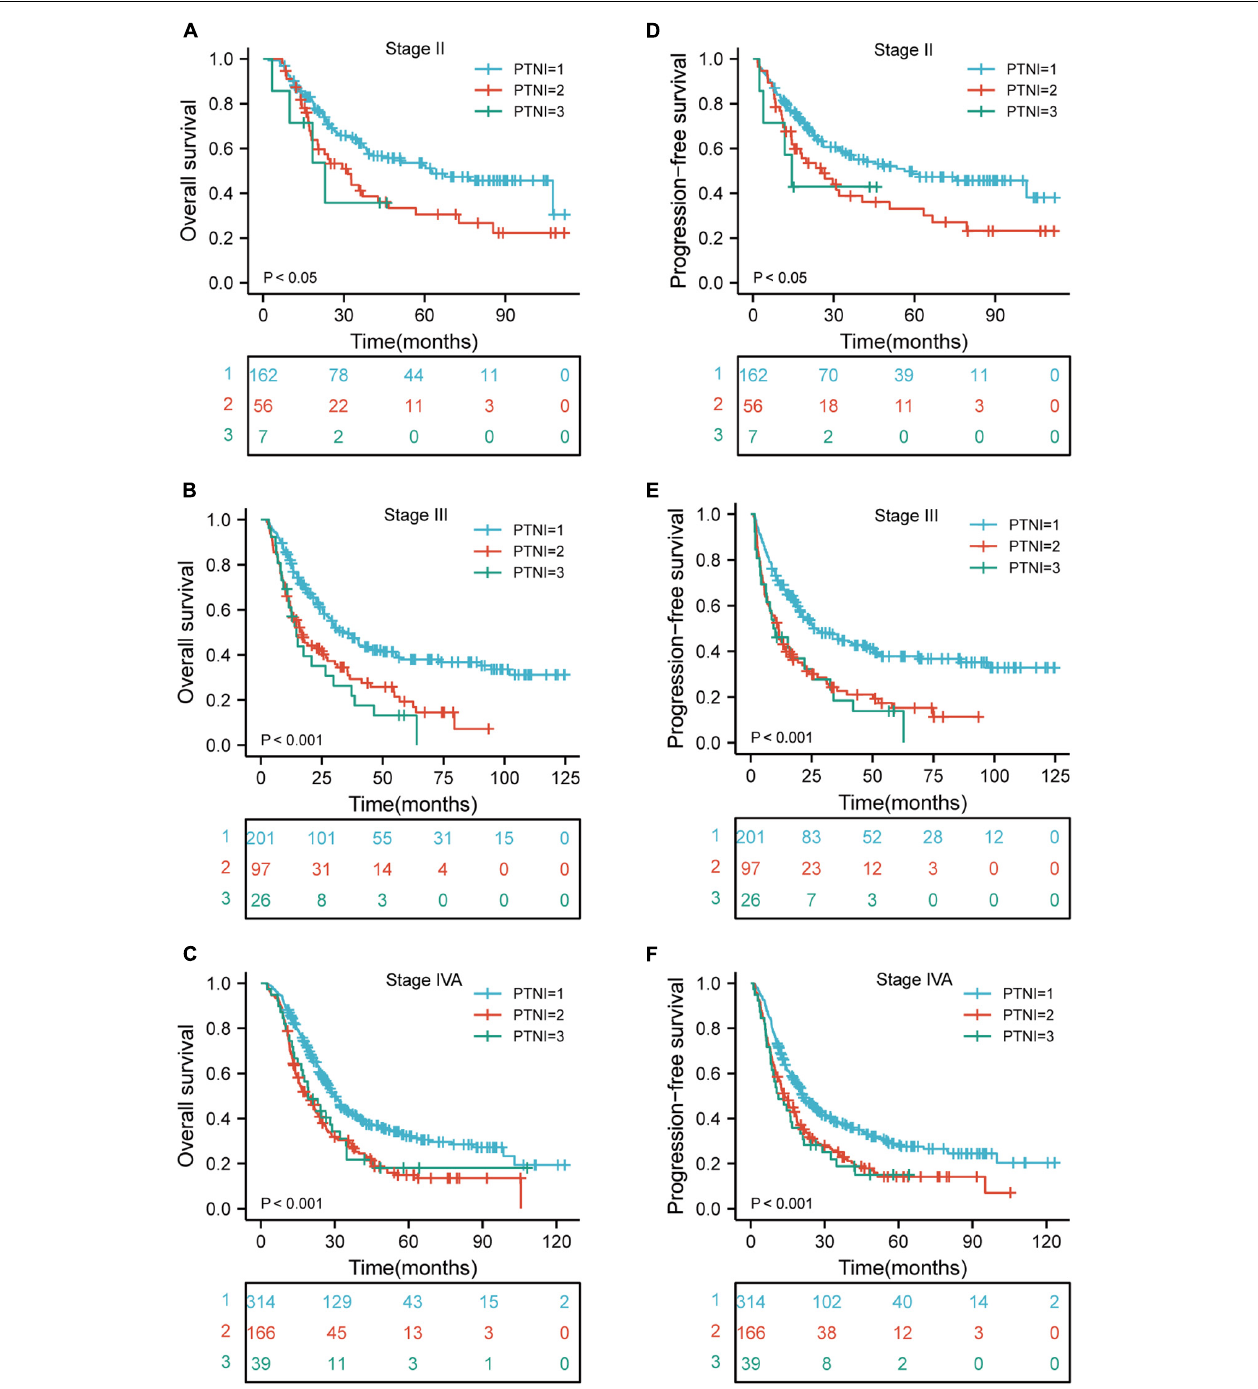
FIGURE 4 | Kaplan-Meier curves according to TNM stage categories for the 1,068 patients showing (A–F) overall survival ( p < 0.05, p < 0.001, p < 0.001, respectively) of patients with TNM stage II, III, and IVA; progression-free survival ( p < 0.05, p < 0.001, p < 0.001, respectively) of patients with TNM stage II, III, and IVA. TNM, tumor-node-metastasis; PTNI, pre-therapeutic nutritional